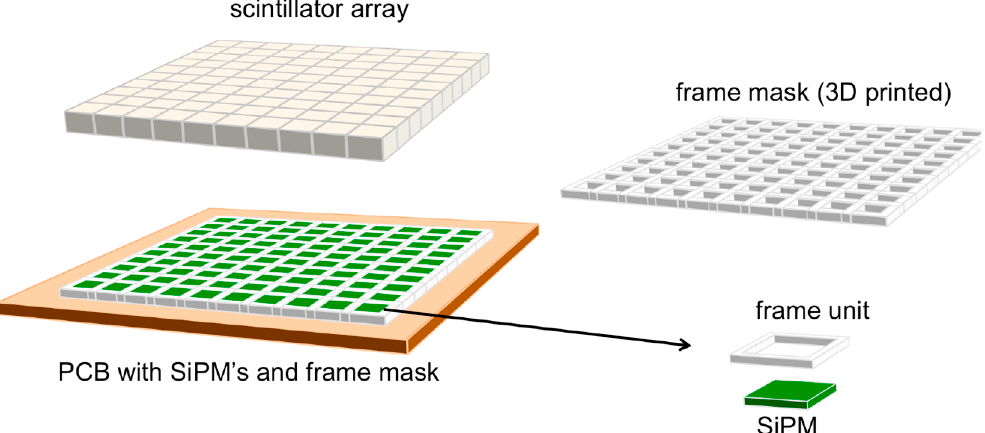
Figure 4. Sketch of the assembly scheme for the detector array. The white reflecting frame mask performs the mechanical alignment between the array of 6 × 6 mm 2 SiPMs and the corresponding 10 × 10 mm 2 scintillators.